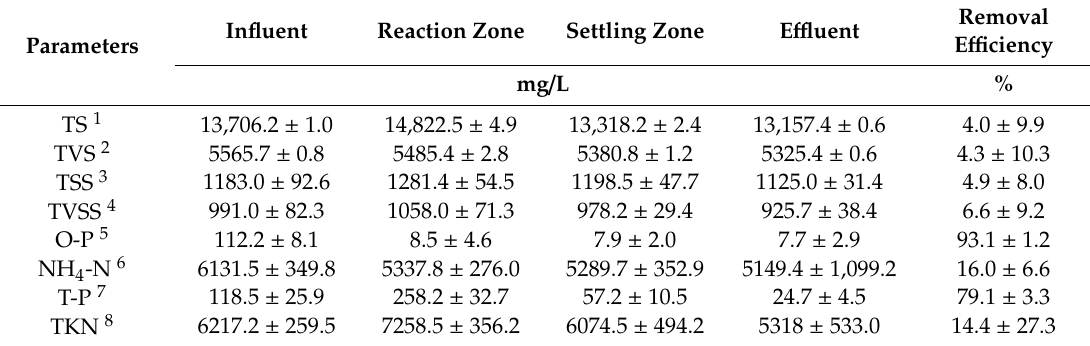
Table 4. Characteristics of the parts of recovery process from the preliminary